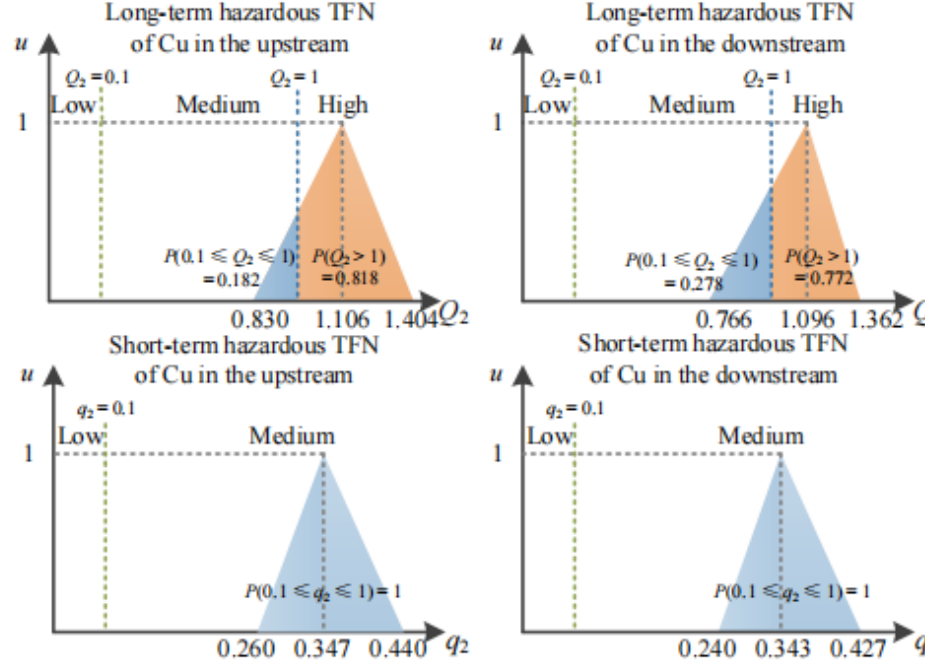
Figure 8. Hazardous TFNs of Cu before dam construction.